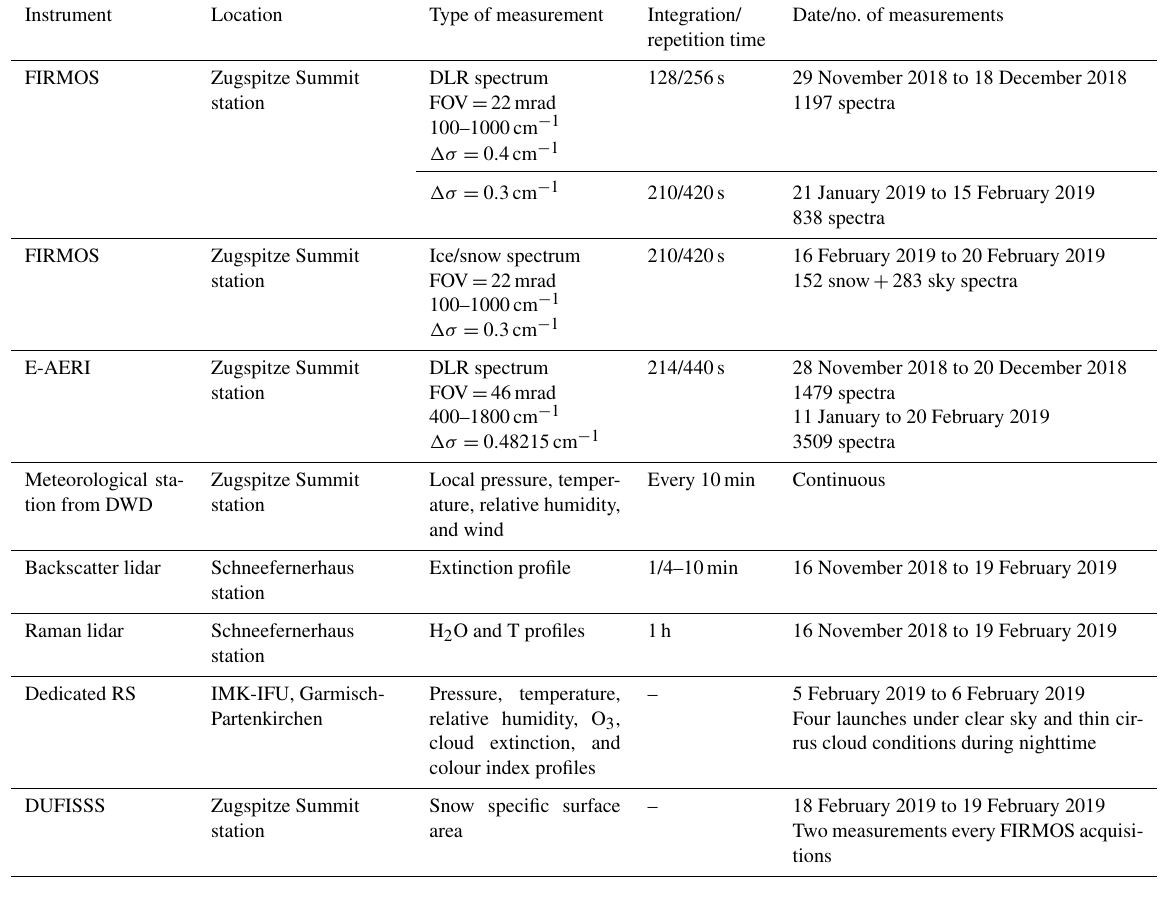
Table 1. Instrumentation deployed at Zugspitze and measurements performed during the FIRMOS campaign and provided in the available dataset.